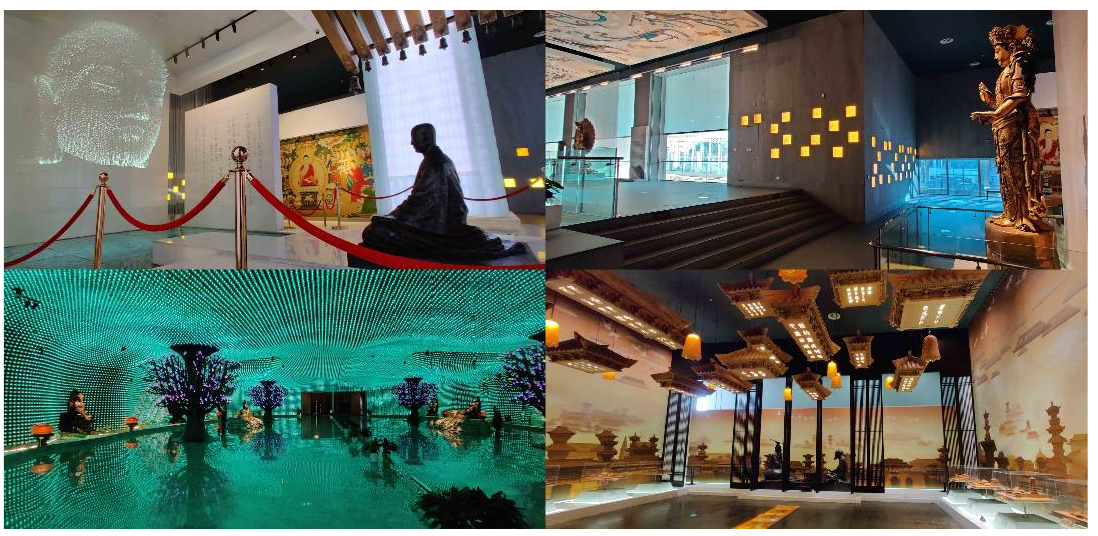
Figure 8. Modern religious space in the Great Bao’en Temple Museum (Source: photo courtesy of Pengfei Ma).